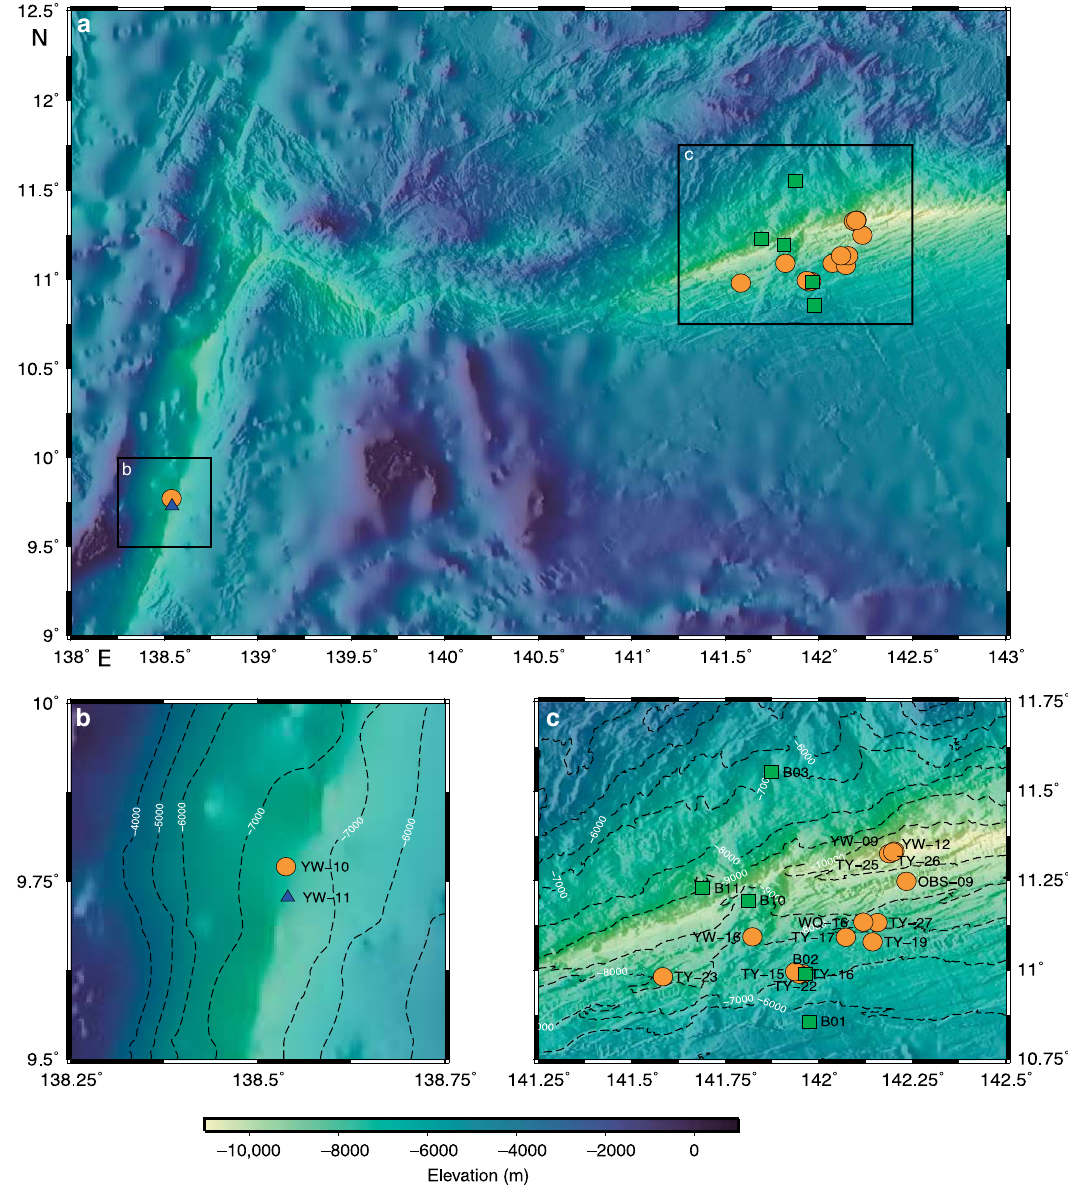
Fig. 1 Location map showing the samples from Mariana/Yap trenches. a Overview of sampling locations, with the inset b for Yap Trench and inset c for Mariana Trench. Sediment (green squares), amphipod (orange circles), and snail fi sh (blue triangle) samples are marked with fi lled